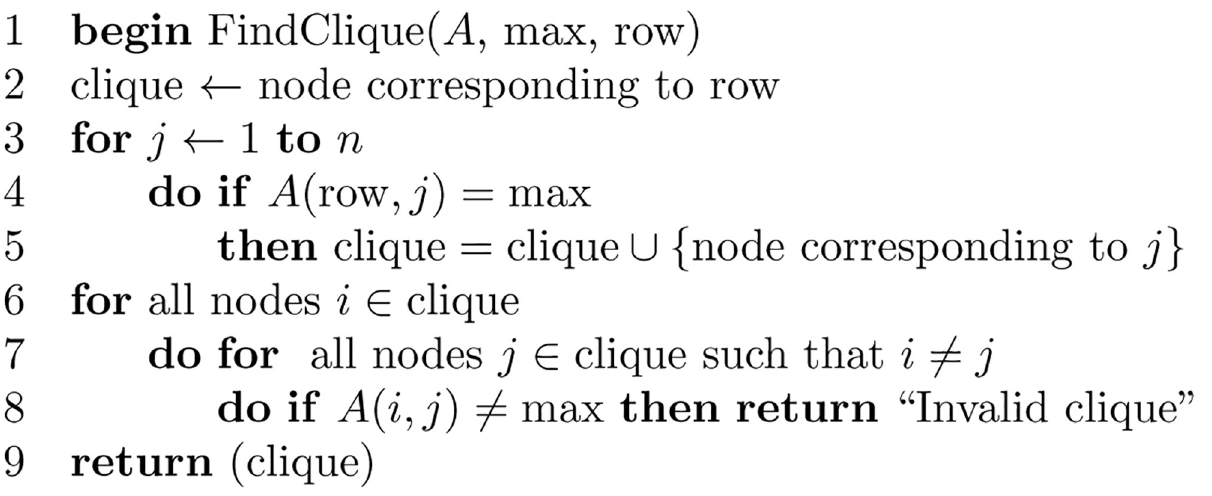
Fig 20. Algorithm to find a clique with edge labels equal max